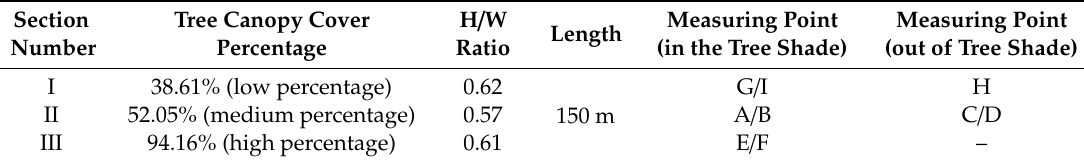
Table 1. Characteristics of the street used for data collection 1 .